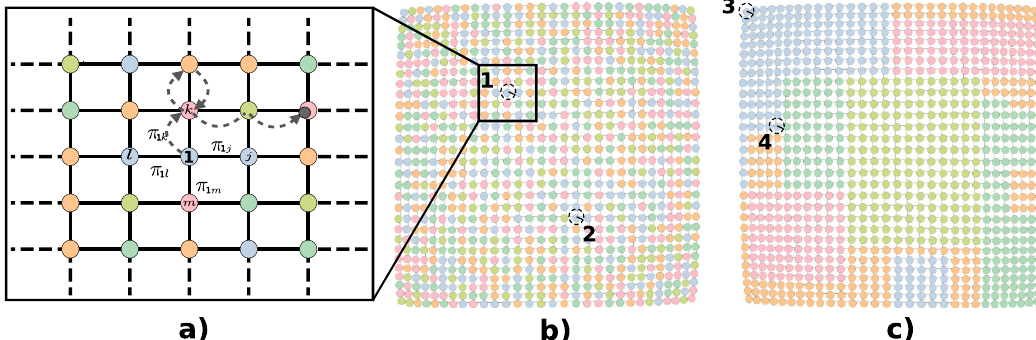
Fig. 1 Characterising colour distributions in regular lattices. The statistics of the amount of time needed to a random walker to hit a node of a given class when starting from another node of the graph encodes useful information about the presence of heterogeneity and correlations in the distributions of node classes. a We show a sketch of the trajectory of a random walker over the grid. We indicate by π 1 k , π 1 l , π 1 m and π 1 j the one-step transition probabilities from node 1 to nodes k , l , m , j , respectively. b The nodes of a square lattice are assigned to one of fi ve available classes uniformly at random. As a consequence, the time needed to a random walker to hit an orange node when starting by node 1 is comparable to the time needed when starting from node 2. c The assignment of nodes to classes creates homogeneous clusters of nodes of the same colour. As a consequence, the time needed to a random walker to hit an orange node when starting from node 3 is much higher than the time needed when starting from node 4. In all the panels the colour of a node corresponds to the class it is assigned